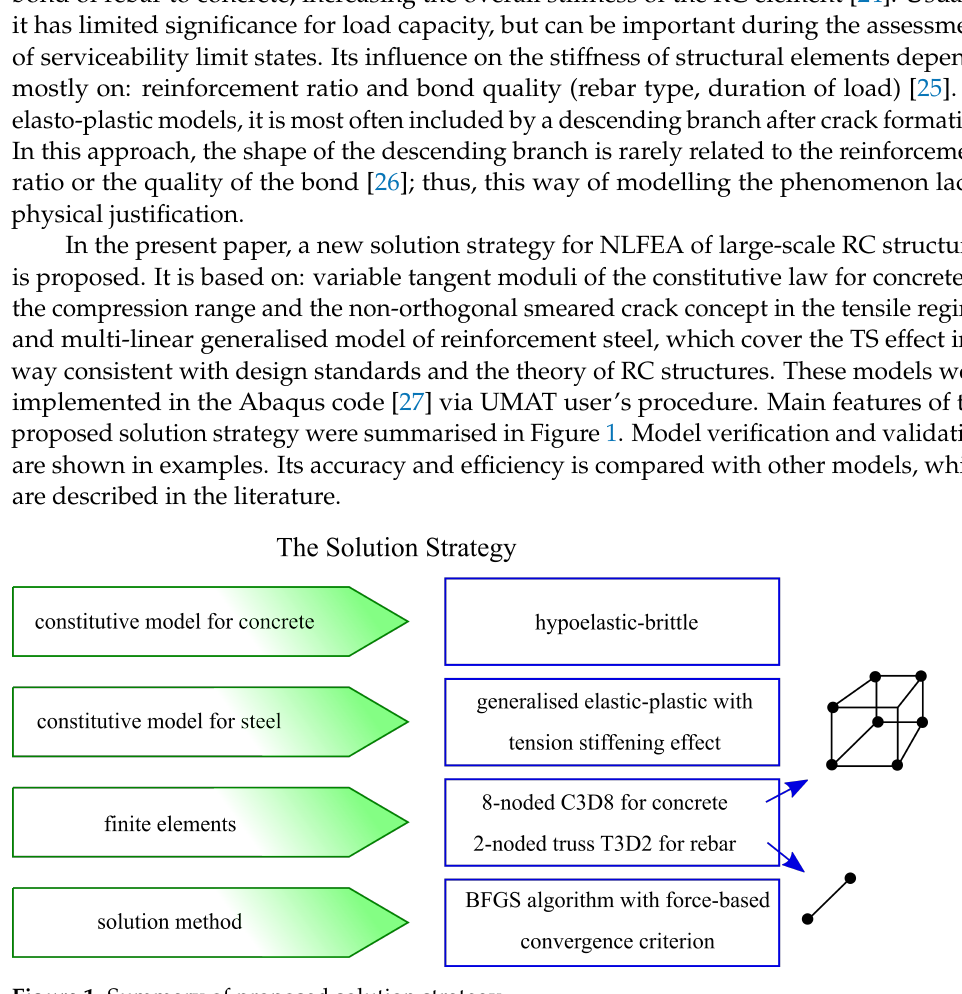
Figure 1. Summary of proposed solution